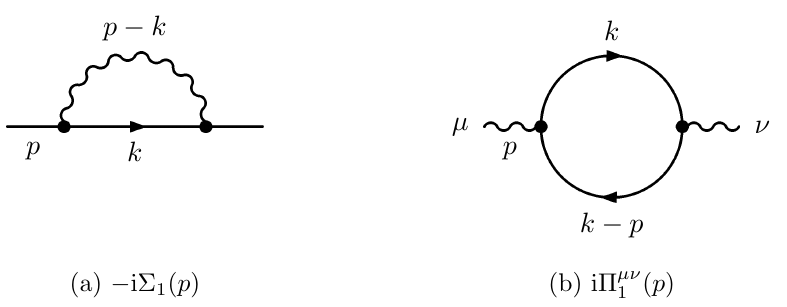
Figure 1 : 1-loop fermion self energy and photon